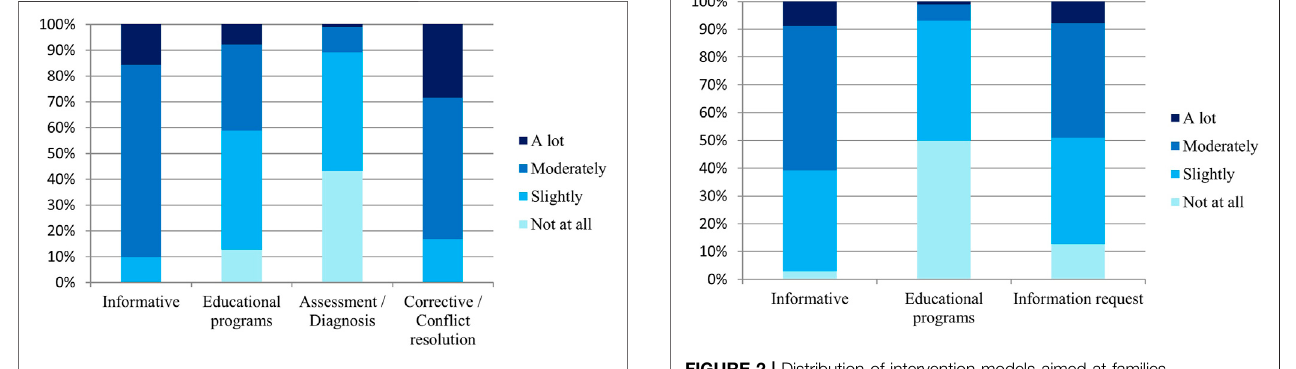
FIGURE 1 | Distribution of intervention models aimed at students.